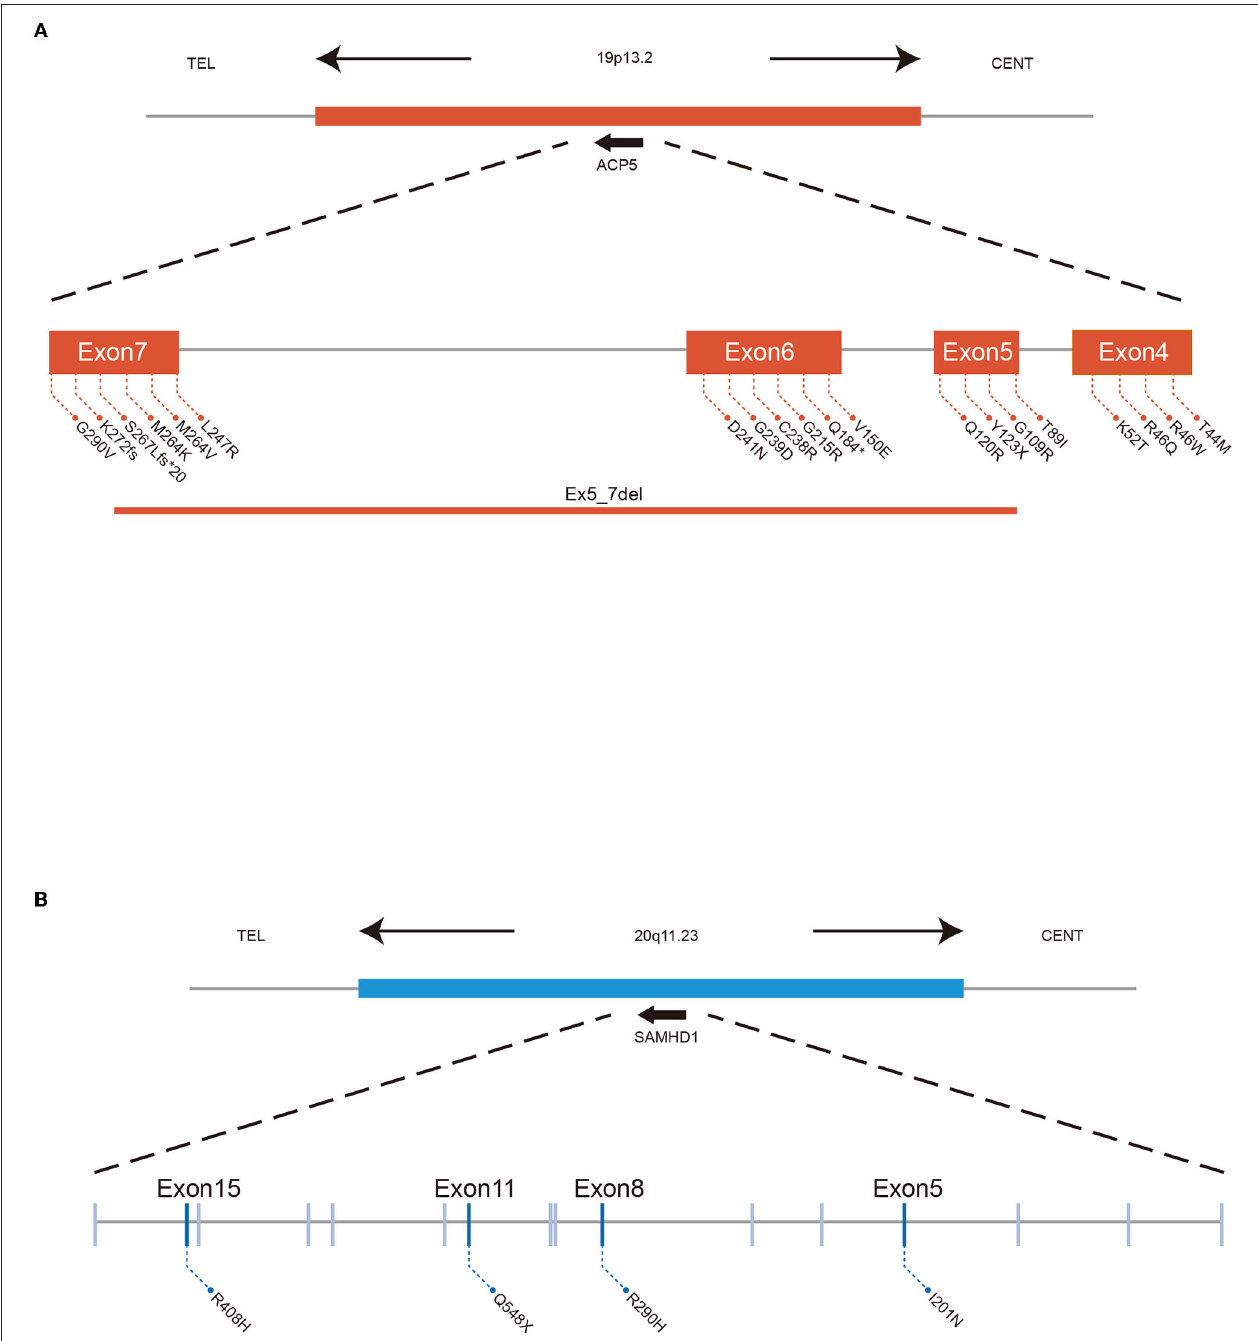
FIGURE 2 | ACP5 mutations cause SPENCD and SAMHD1 mutations cause AGS both diseases clinically overlap with SLE, and both are associated with a spontaneous type I IFN response. (A) Summary of ACP5 mutation associated with SLE data. (B) Summary of SAMHD1 mutation associated with SLE data.